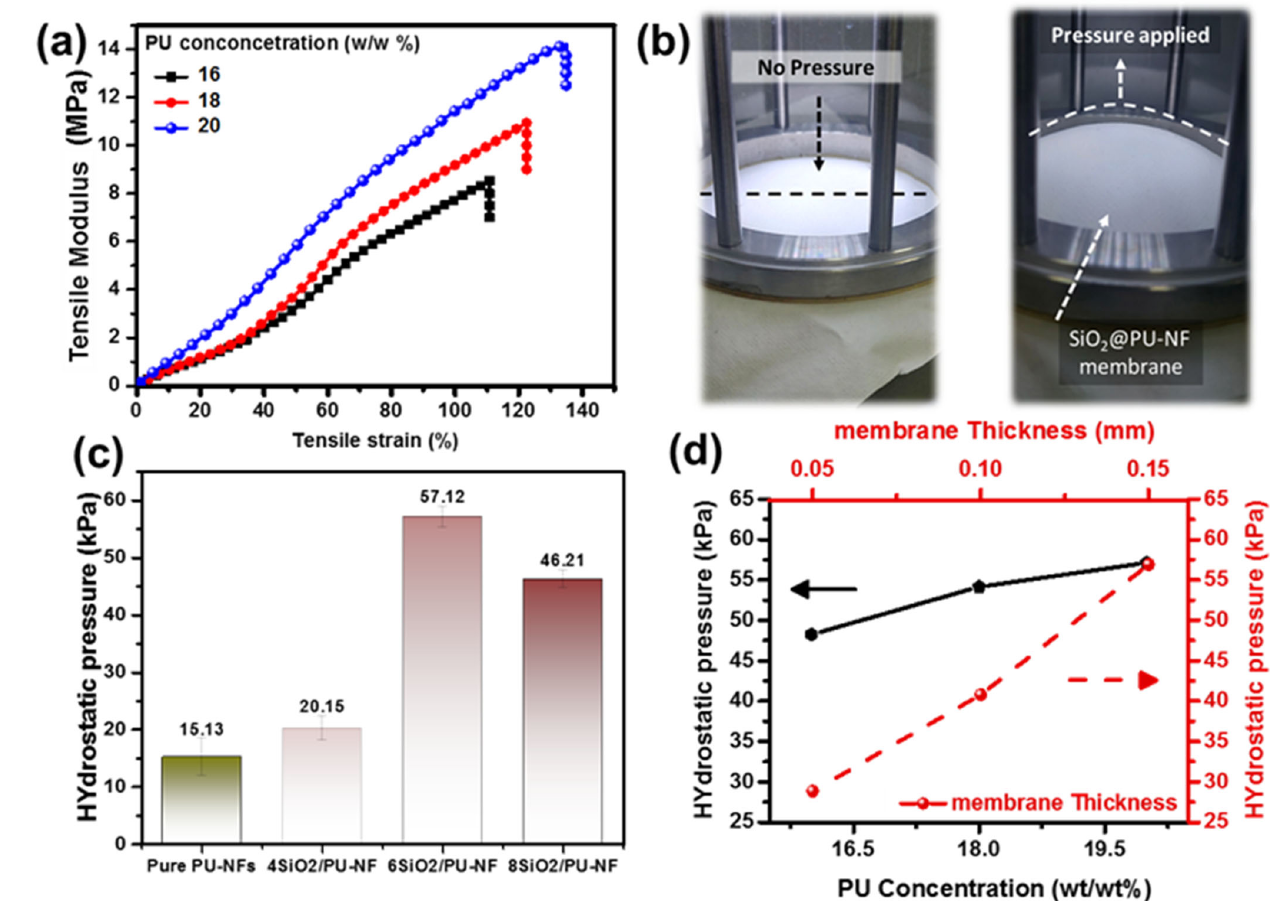
Figure 7. ( a ) Impact of PU concentration on the mechanical performance of the composite nano- fi brous membrane; ( b ) photographic view of SiO 2 @PU − NFs membrane under hydrostatic pressure; ( c ) hydrostatic pressure of pristine PU − NFs and SiO 2 PU − NFs membranes; ( d ) impact of the PU con- centrations and membrane thickness on the hydrostatic pressure of the composite nano fi brous membrane.